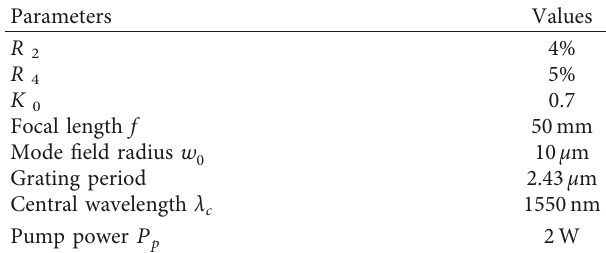
Figure 5: Er 3+ absorption-emission cross-sections. Table 1: Relevant simulation parameters.